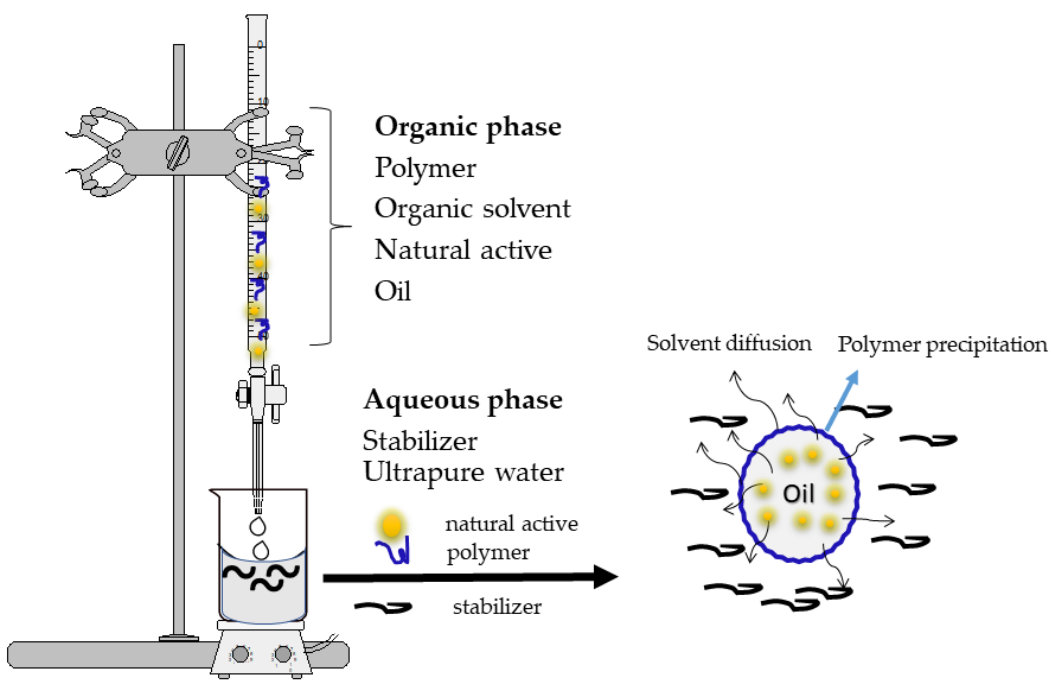
Figure 3. Formation of polymeric nanoparticles using the nanoprecipitation method. The organic phase consists of a solution—or a mixture—of a polymer (carrier), the organic solvent, the active substance (natural active ingredient), oil and a lipophilic surfactant. The aqueous phase consists of a mixture of surfactant (stabilizer) and ultrapure water. Using a burette and a magnetic stirrer, the organic phase is slowly added to the aqueous phase.